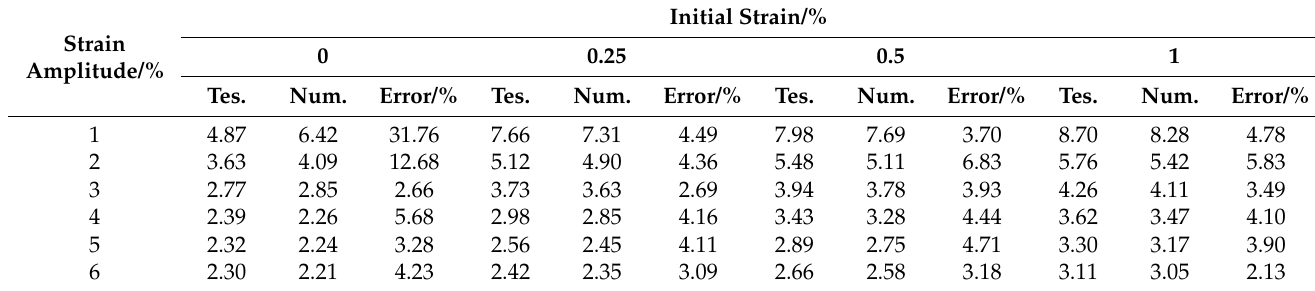
Table 10. Comparison of secant stiffness under different initial